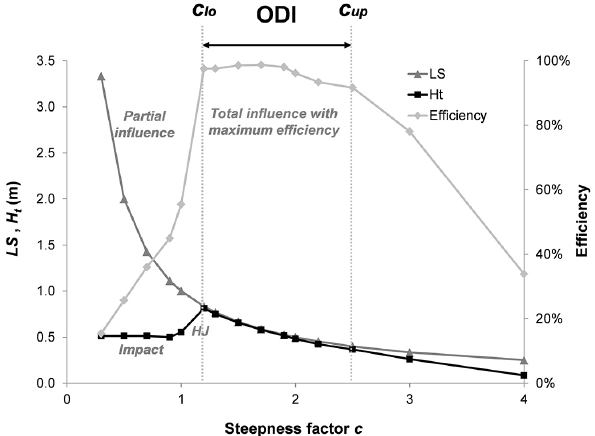
Fig. 7. Profiles of the main energy parameters as a function of the steepness factor c in dam-filling conditions ( q =0.1m 2 s − 1 ; S =20%; n =0.04; z =1m). “Impact” refers to the impact losses as the predominant dissipation process and “HJ” to the interval where the energy losses at the hydraulic jump become increasingly relevant. c lo represents the lower threshold of ODI; c up the upper threshold of ODI; H t the total energy dissipated ( H i + H j ); LS the difference in total head between adjacent dams; and ODI the opti- mal dissipation interval.